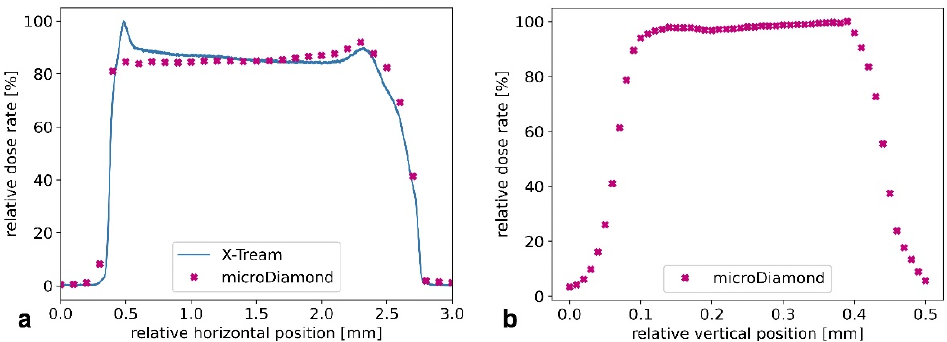
Figure 4. Characterizing the field size and shape at the white-beam beamline with different dosim- eters. Horizontal ( a ) and vertical ( b ) profiles, measured around the beam central axis. These data, obtained with the microDiamond (points) and the X-Tream dosimetry system (line), are used as input properties in the Monte Carlo simulation. The error bars are as large as the symbol representing the experimental values.